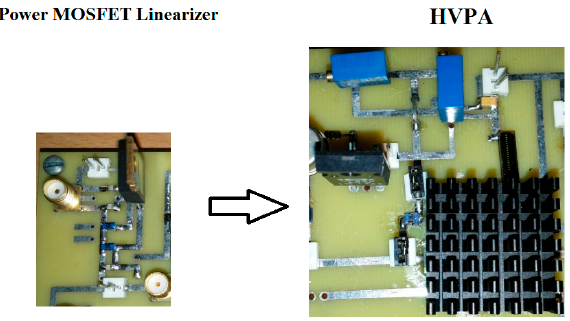
Figure 4. The implemented power MOSFET linearizer and HVPA on a printed circuit board.